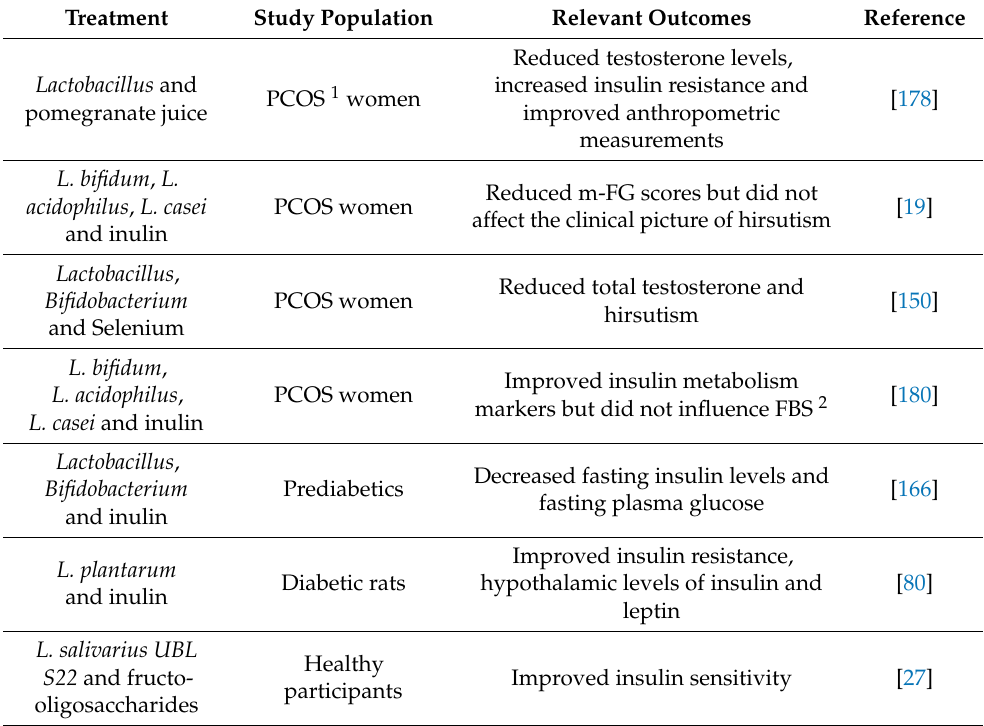
Table 2. Synbiotic treatments and the hirsutism-relevant outcomes.